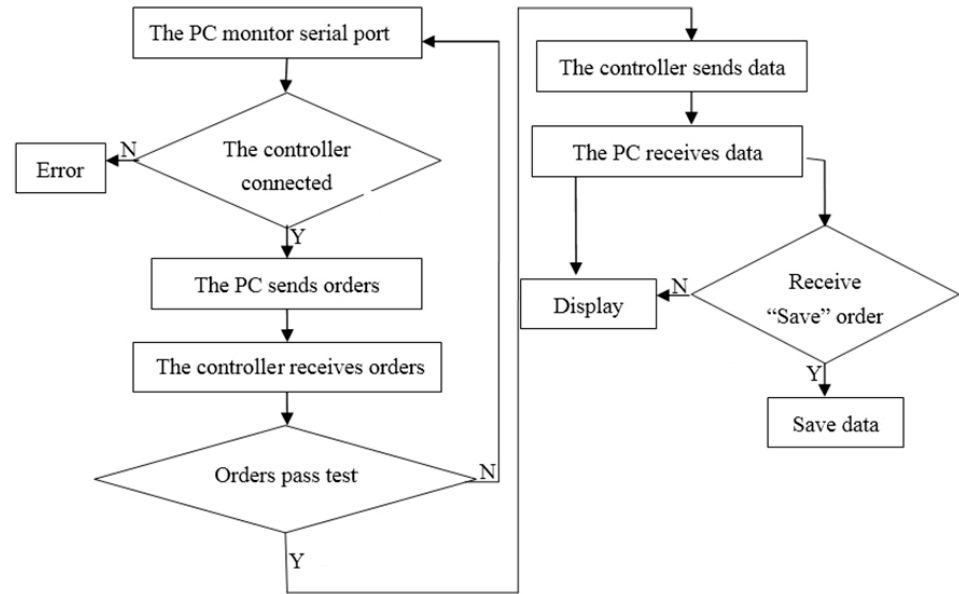
Figure 9. Flow chart of the data communication between the slave and host computers.